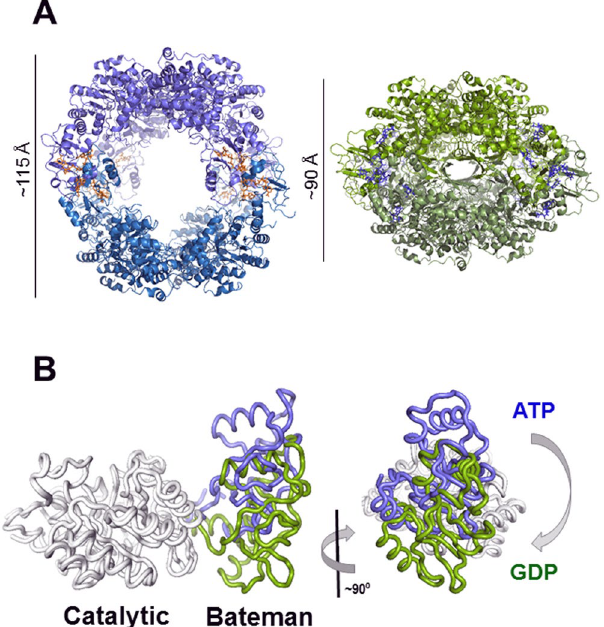
Figure 2. The conformational switch of AgIMPDH. ( A ) High-resolution structures of AgIMPDH in complex with ATP (left panel in blue cartoons) and GDP (right panel in green cartoons 5 ). ATP and GDP molecules are shown in orange and blue sticks, respectively. ( B ) Ribbon representation of monomers of AgIMPDH bound to ATP (blue) or GDP (green), with the catalytic domain